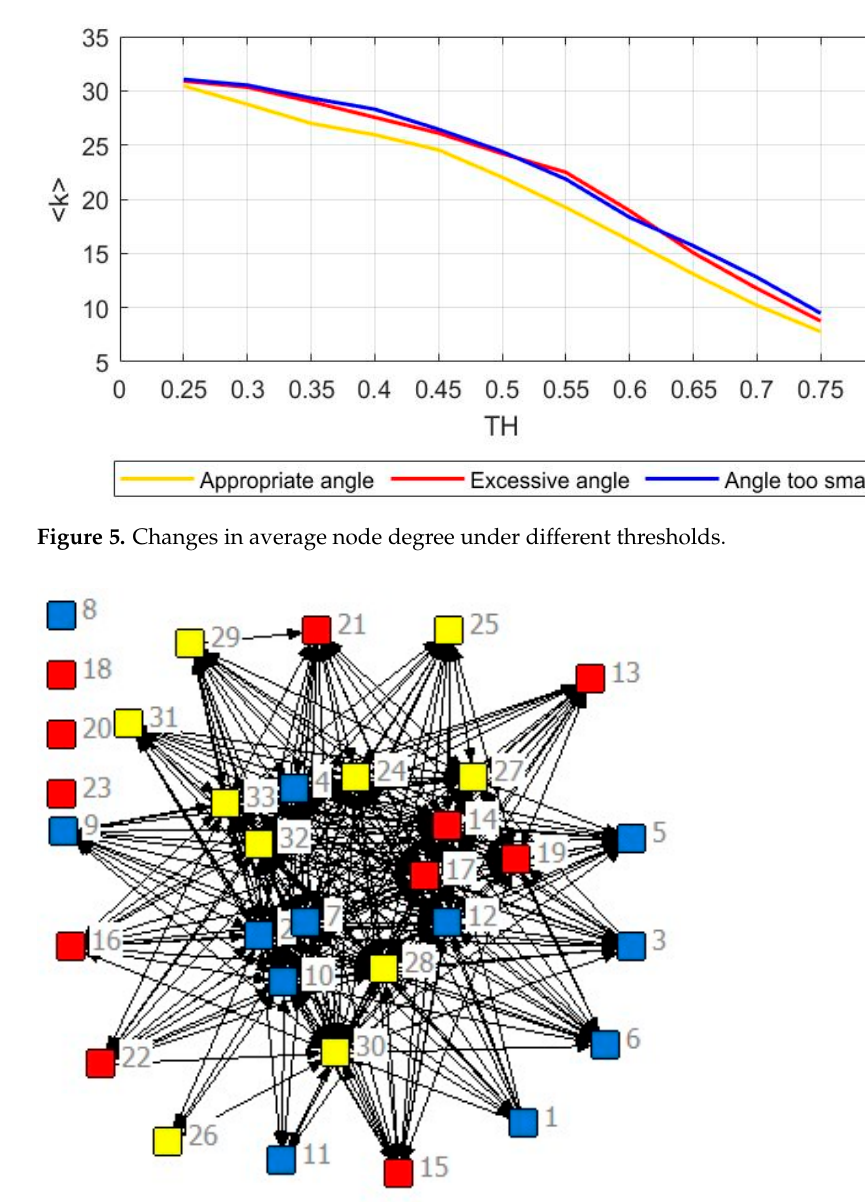
Figure 6. The network of appropriate angle with the threshold TH = 0.60. There are four isolated nodes, V8, V18, V20, and V23.